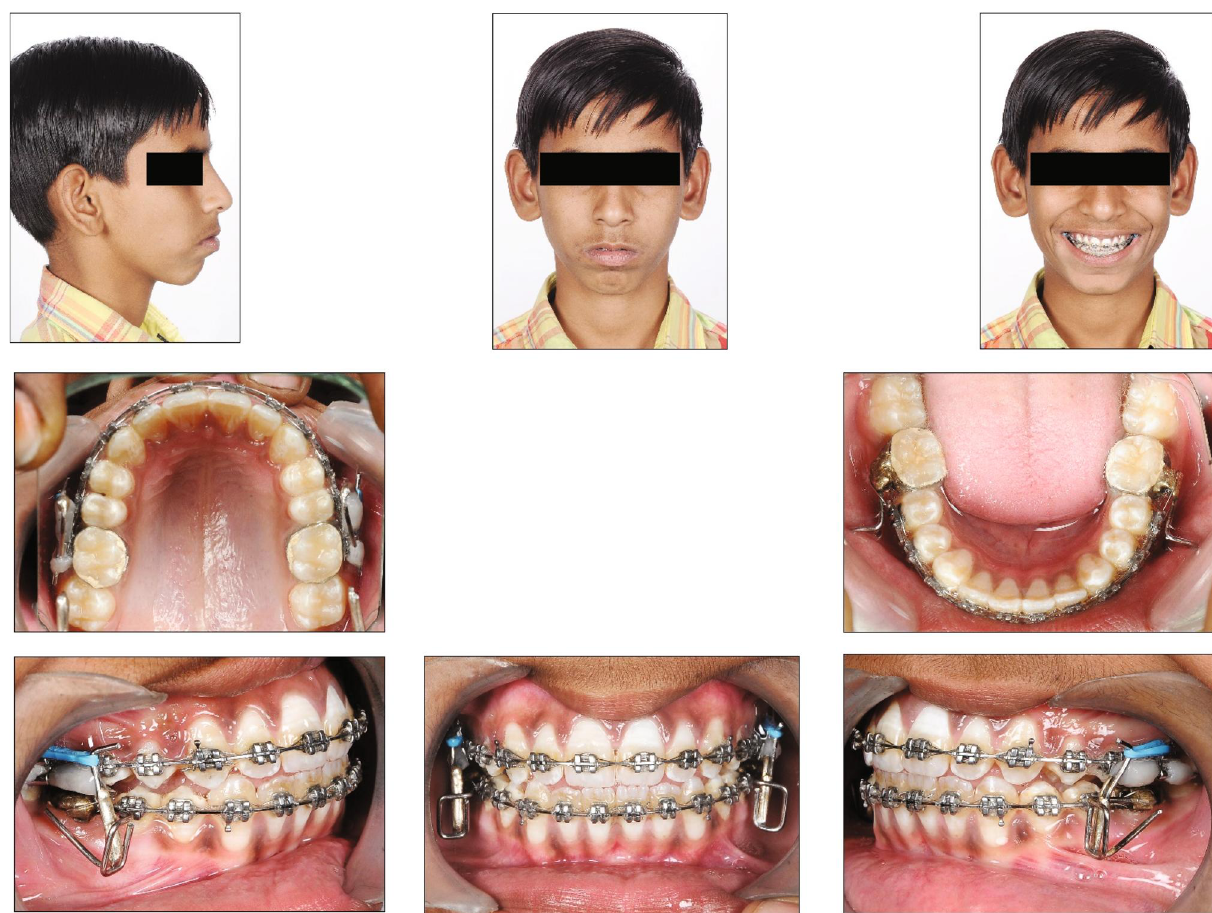
Figure 3: With in-house fabricated , customized FM2 JET appliance photographs and radiographs.